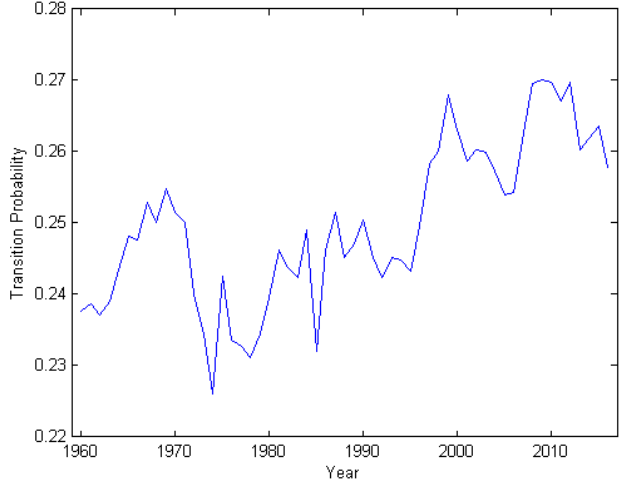
Figure 8. The change of the transition probability to the compound dry and hot extreme during 1960– 2016 for Melbourne,